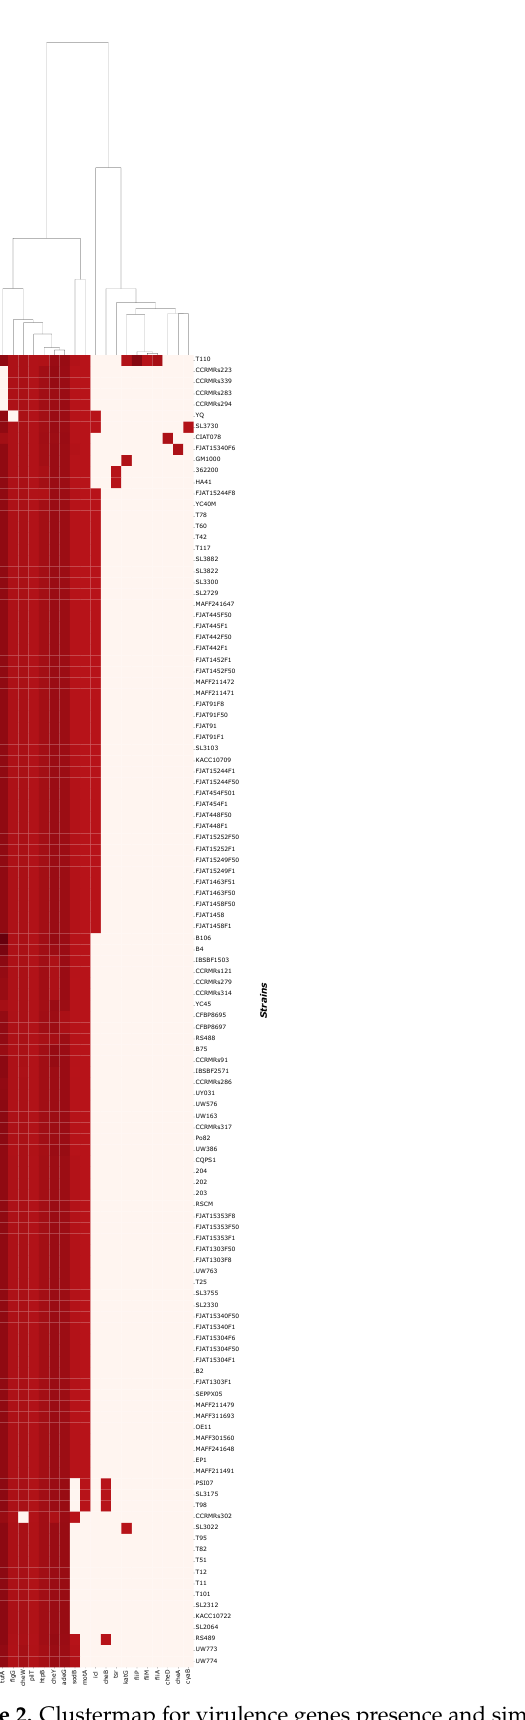
Figure 2. Clustermap for virulence genes presence and similarity against